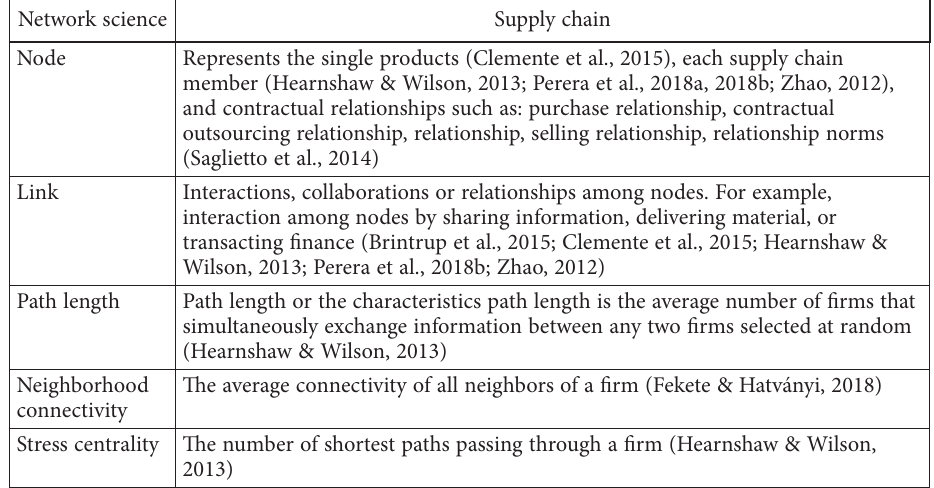
Table 2. Equivalent definition of information sharing network from network science (source: authors’ own study) Network science Supply chain